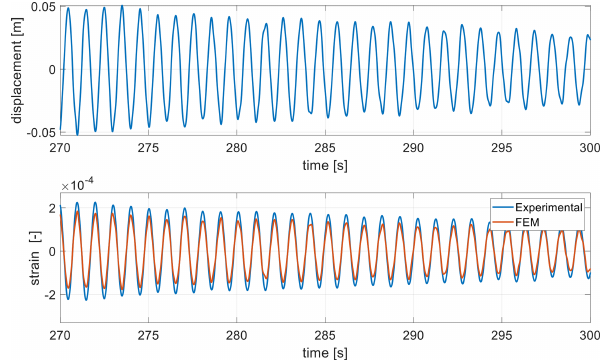
Figure 10. Displacement and strain time histories during